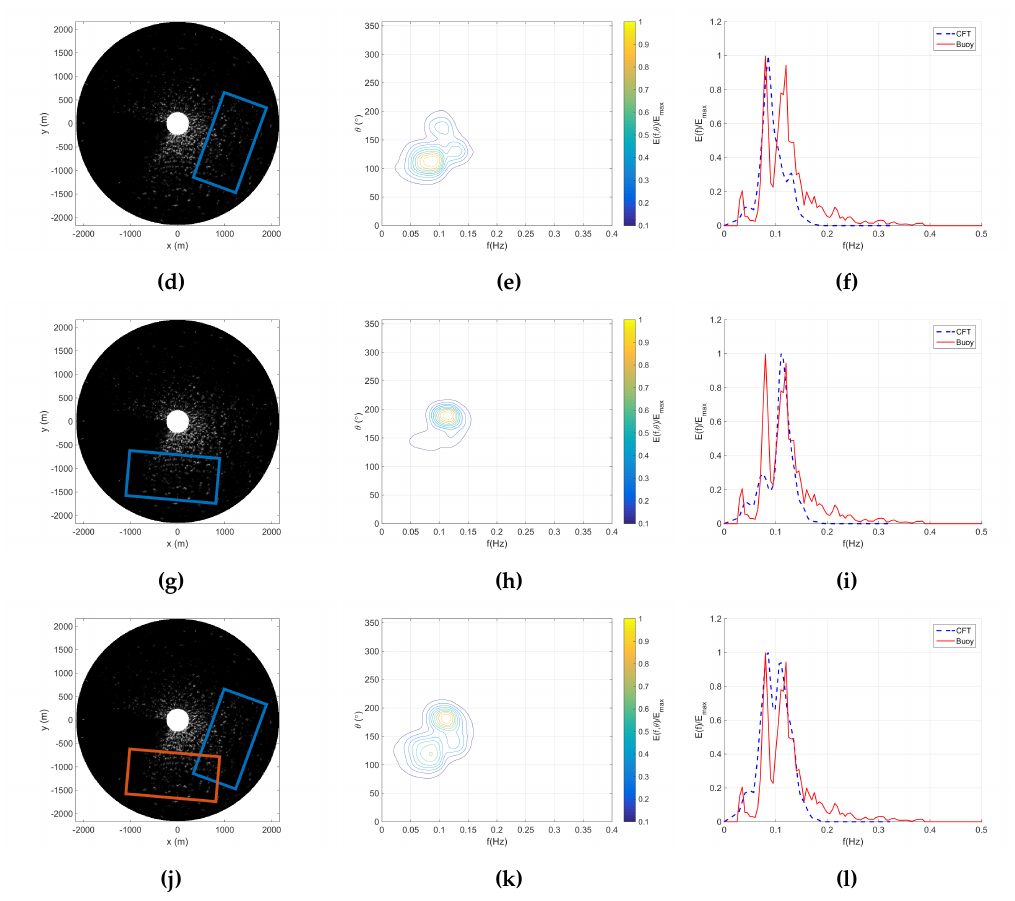
Figure 4. A field data example for wave spectrum estimation dependency on azimuth direction( a–l